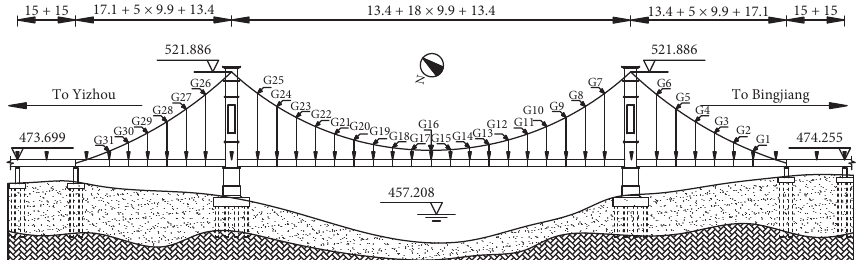
Figure 2: Elevation view of the Yunlongwan Bridge (unit: m).